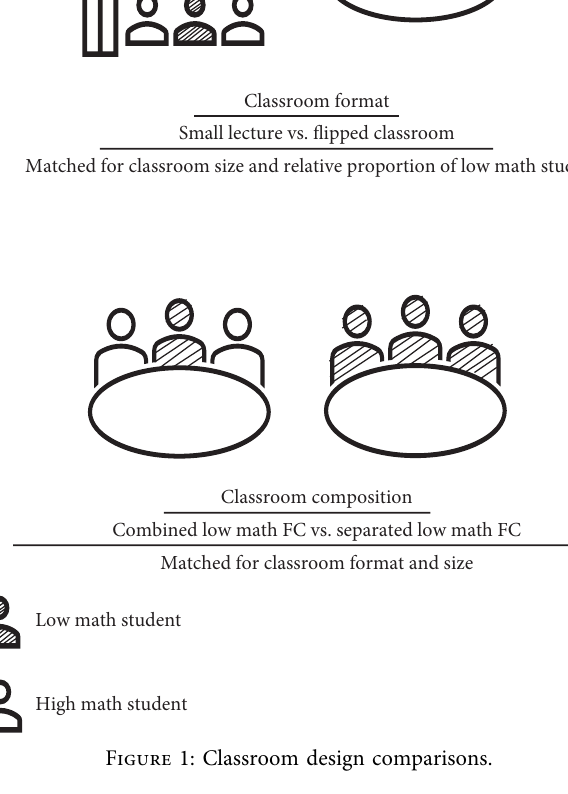
Figure 1: Classroom design